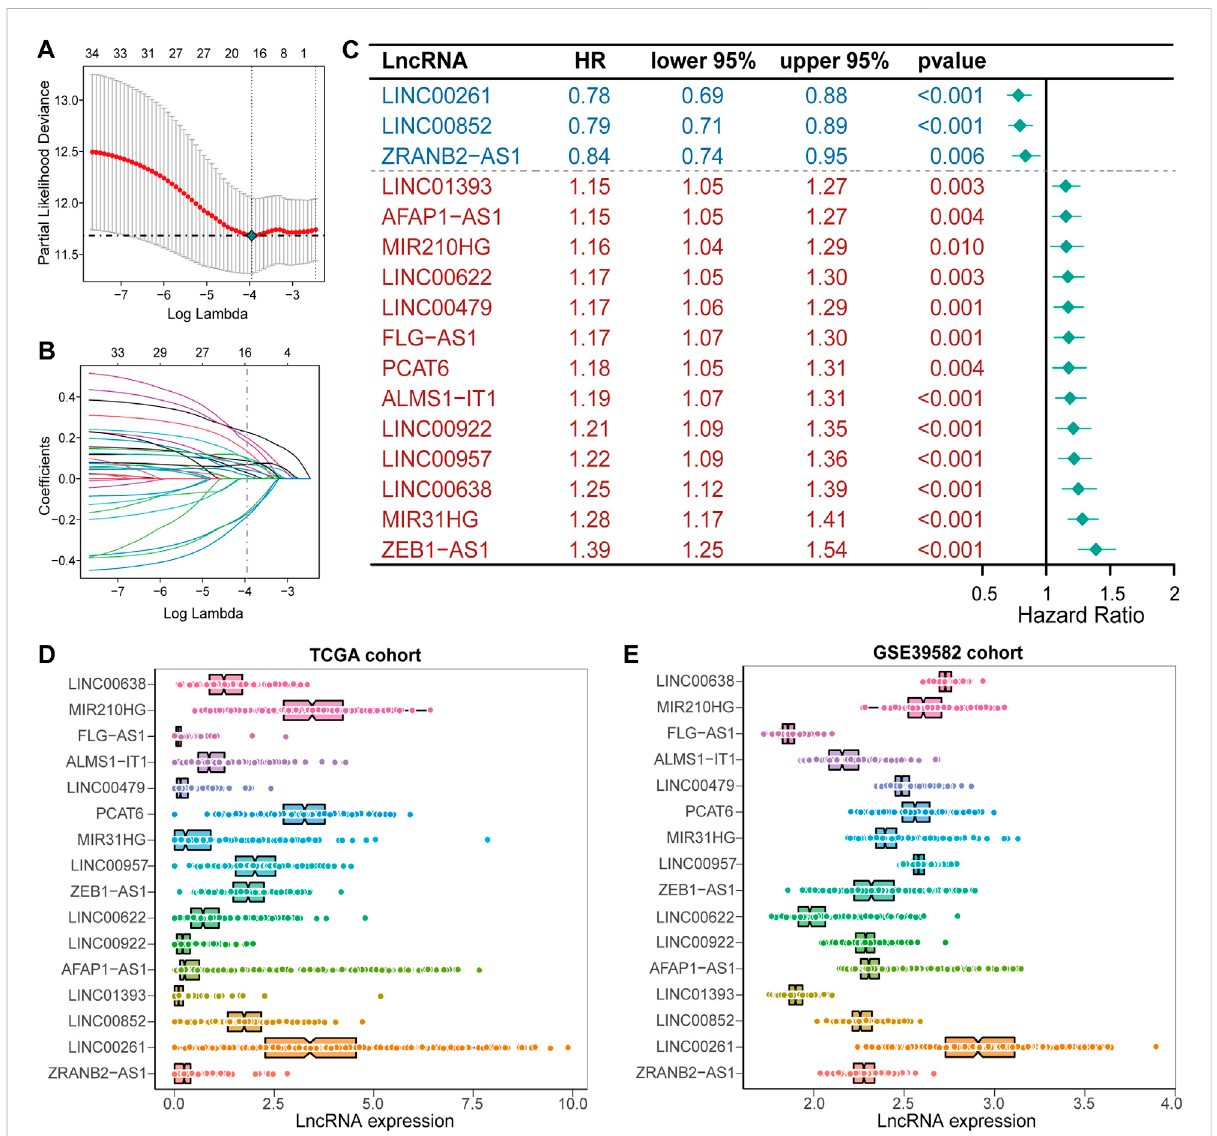
FIGURE 1 Constructionoftheprognosticsignature,IRLncSig (A)